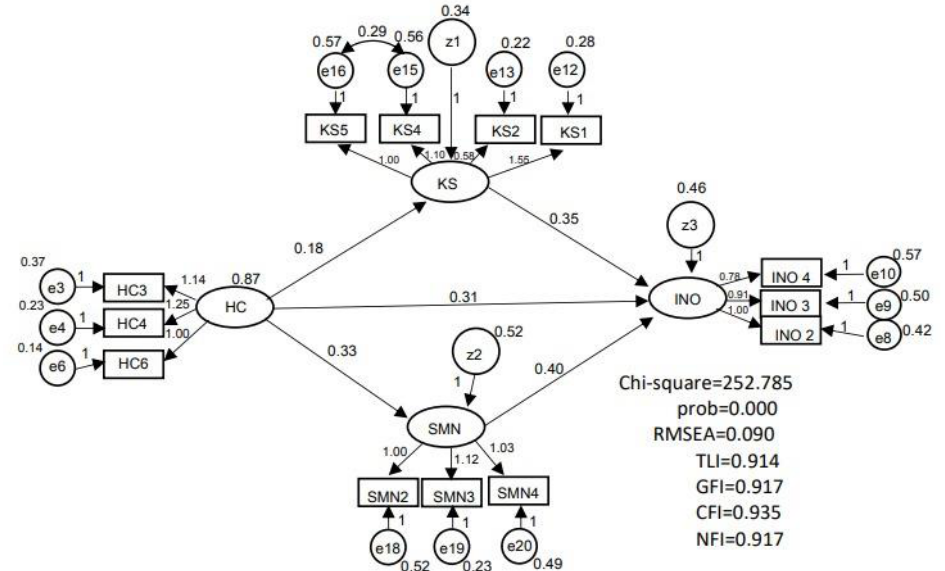
Figure 2 and Table 4 present the results of hypothesis testing using path analysis.